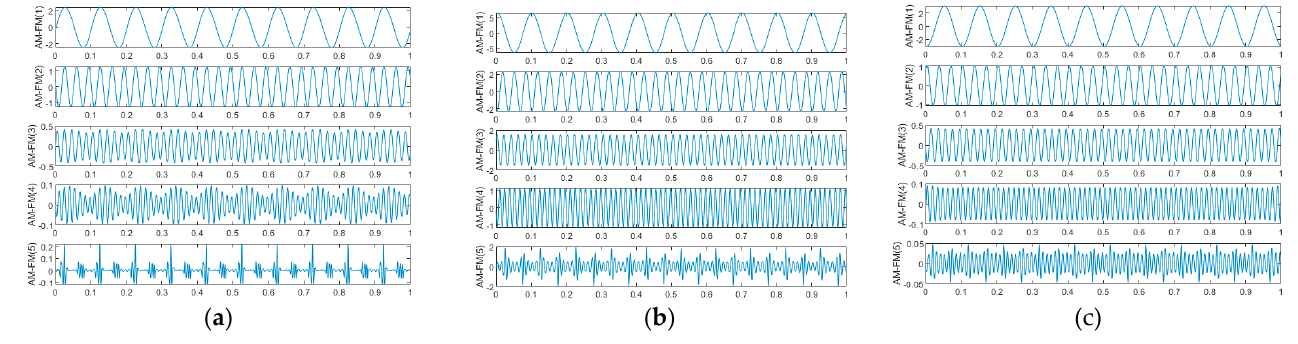
Figure 11. AM-FM components of the responses of fault-free CUT based on improved EWT: ( a ) components of the Sallen–Key bandpass filter circuit response; ( b ) components of the CSTV filter circuit response; and ( c ) components of the leap-frog low-pass filter circuit response.